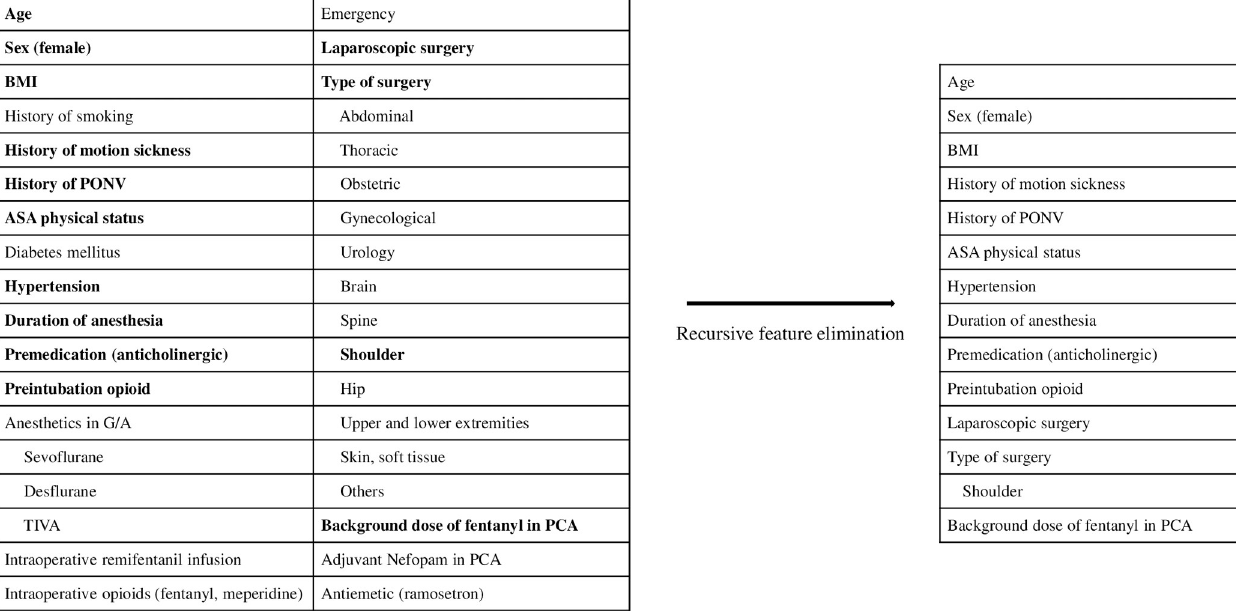
Fig 2. Feature selection process by recursive feature elimination on the training